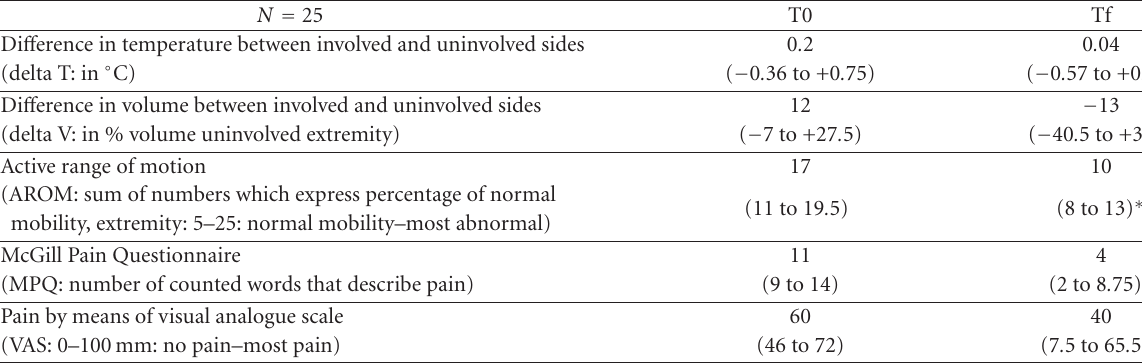
Table 2. Signs and symptoms of impairment in the study population at first measurement (T0) and follow-up measurement (Tf). Data are presented as median ± interquartile range. N = 25 T0 Tf Di ff erence in temperature between involved and uninvolved sides 0 . 2 0 .